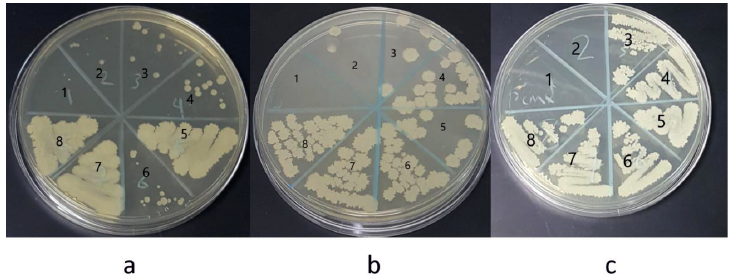
Fig. 5. K. pneumoniae MBC (a) Sodium hypochlorite #1 = 33320µg/ml, (b) Benzalkonium chloride #1 = 138 µg/ml and (c) Chloroxylenol #2 = 75µg/ml.